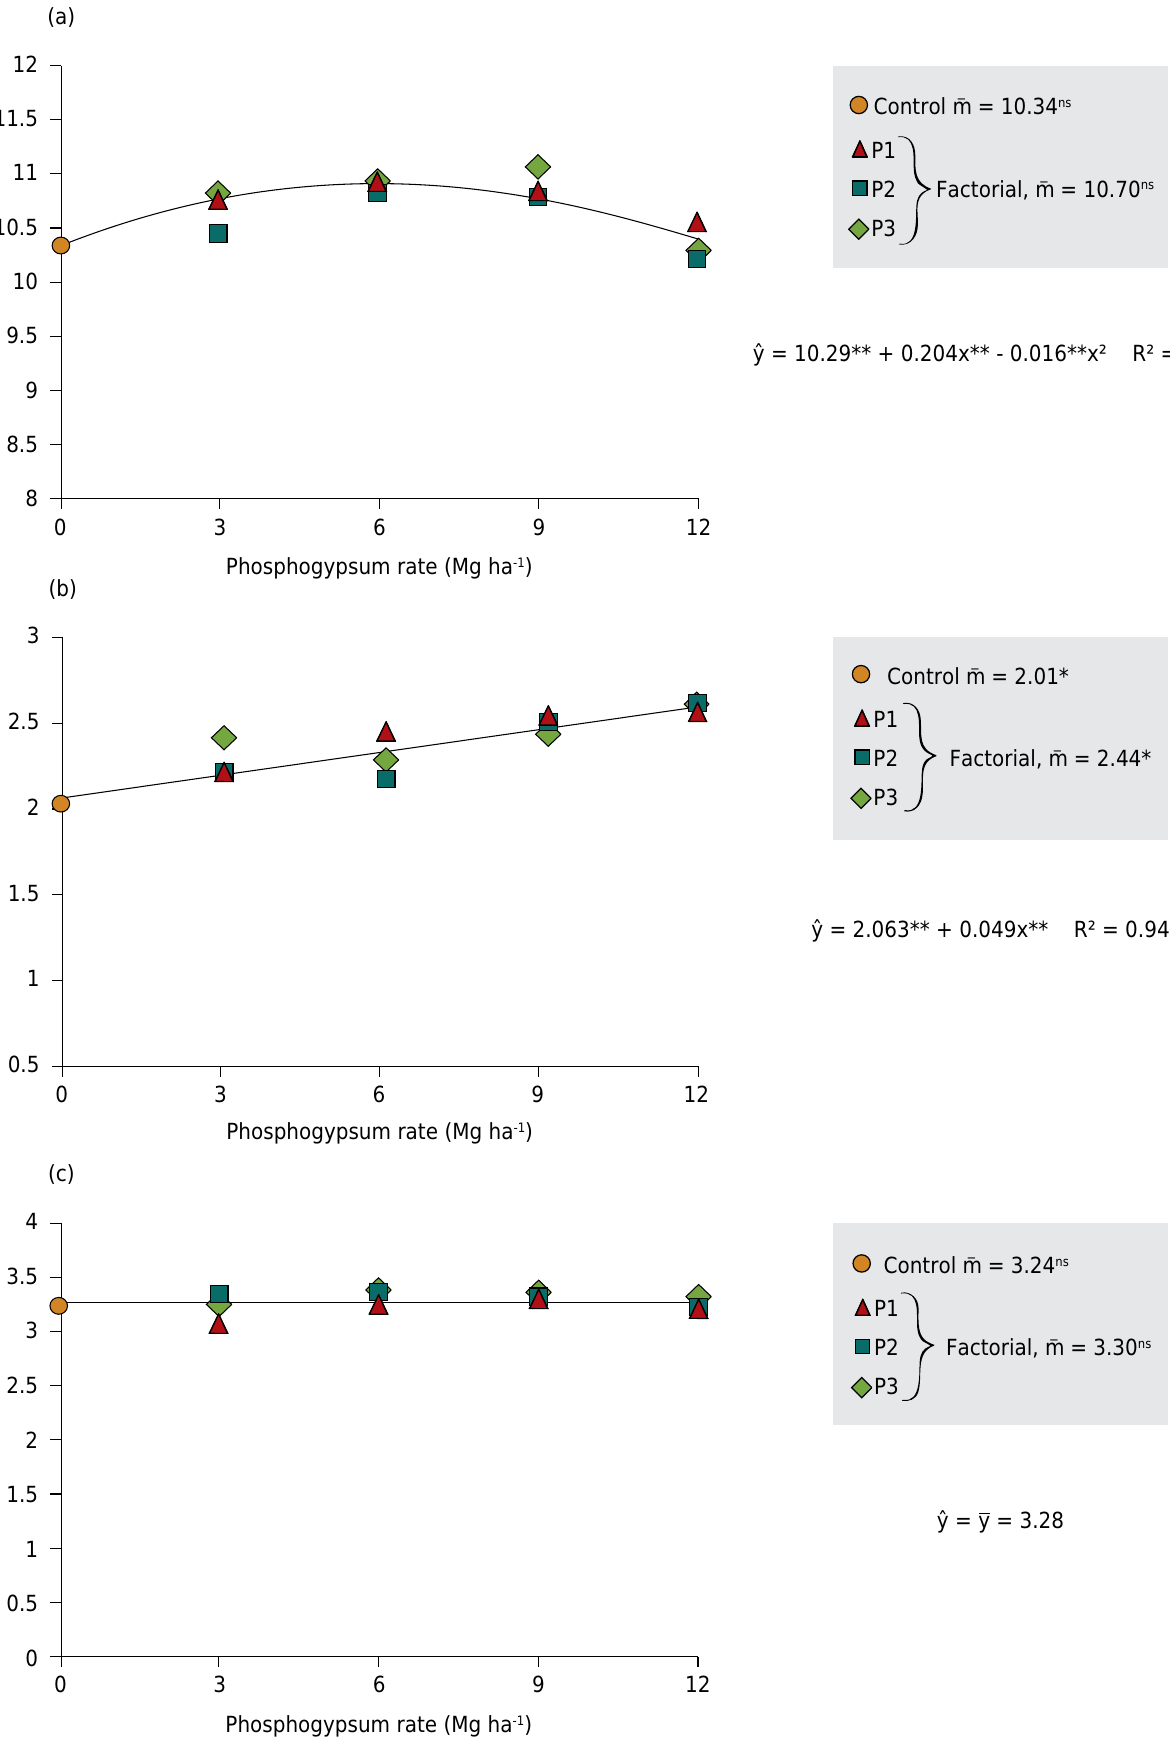
Figure 2. (a) Corn yield (growing season 2011/12), (b) Wheat yield (growing season 2012) and (c) Soybean yield (growing season 2012/13), as a function of different total and split phosphogypsum application rates (P1 = 100 % in 2009; P2 = 50+50 % in 2009 and 2010; P3 = 33+33+33 % in 2009, 2010 and 2011) to the soil surface of a Typic Hapludox, under no-tillage.* and **: significant at p<0.05 and p<0.01, respectively; ns: not